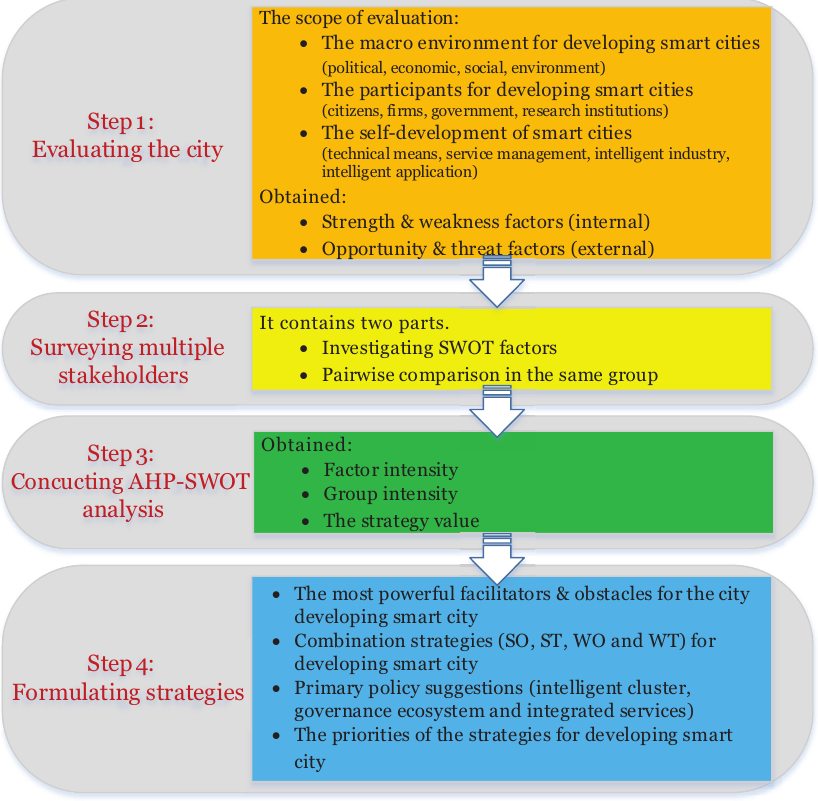
Figure 10. The roadmap for other cities developing